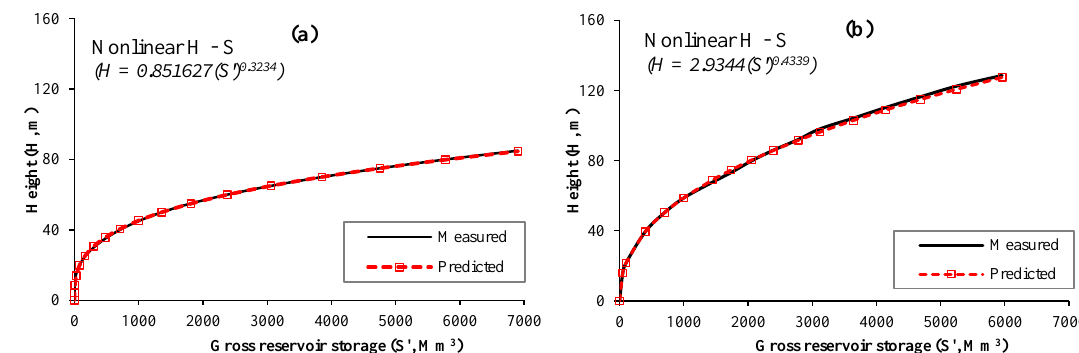
Figure 6. Available and predicted mean nonlinear H–S for the ( a ) Pong and ( b ) Bhakra reservoirs.